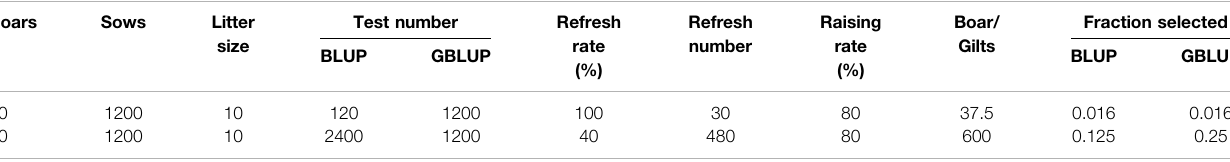
TABLE 1 | Simulation group structure composition and update strategy. Boars